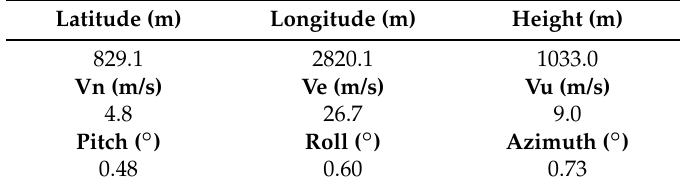
Table 5. RMS of navigation errors for conventional INS with NAV440 in static mode.